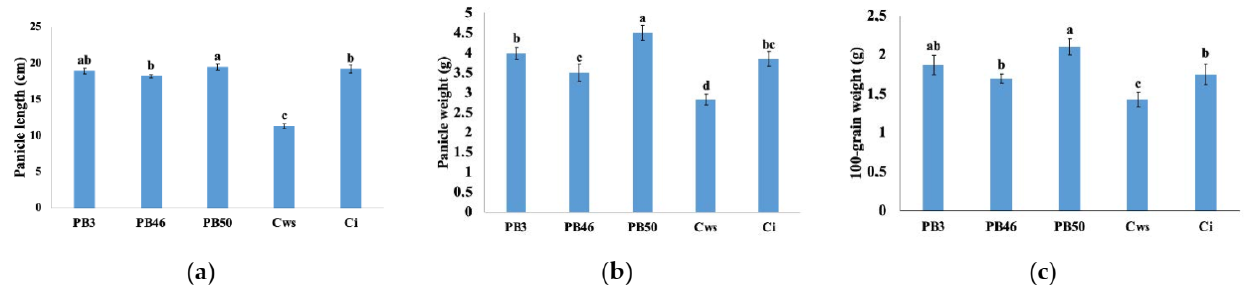
Figure 5. Bar graphs representing means and SD of the yield parameters: Panicle length ( a ), weight ( b ), and grain weight ( c ) of the rice plants of different treatments. PB3, drought stress with B. endophyticus PB3 foliar spray; PB46, drought stress with B. altitudinis PB46 foliar spray; PB50, drought stress with B. megaterium PB50 foliar spray; Cws, drought stress control; and CI, irrigated control. Values with different letters (above the bars) are significantly different according to Duncan’s test ( p ≤ 0.05).